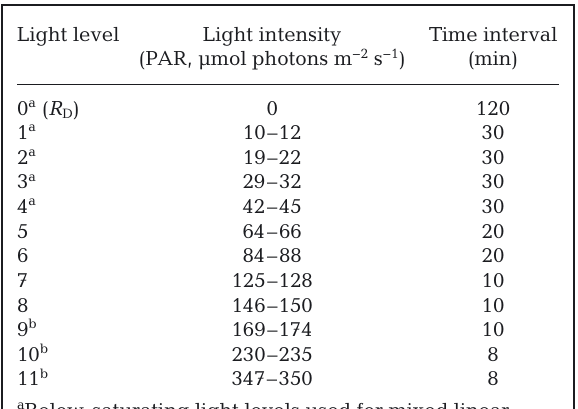
Table 1. Light levels used to generate photosynthesis– irradiance curves for juvenile Saccharina latissima . Values presented are the range (min. to max.) of measured light intensity, and time held, at each light level. α : photosyn- thetic efficiency, I C : compensation irradiance, PAR: photo- synthetically active radiation, P MAX : photosynthetic